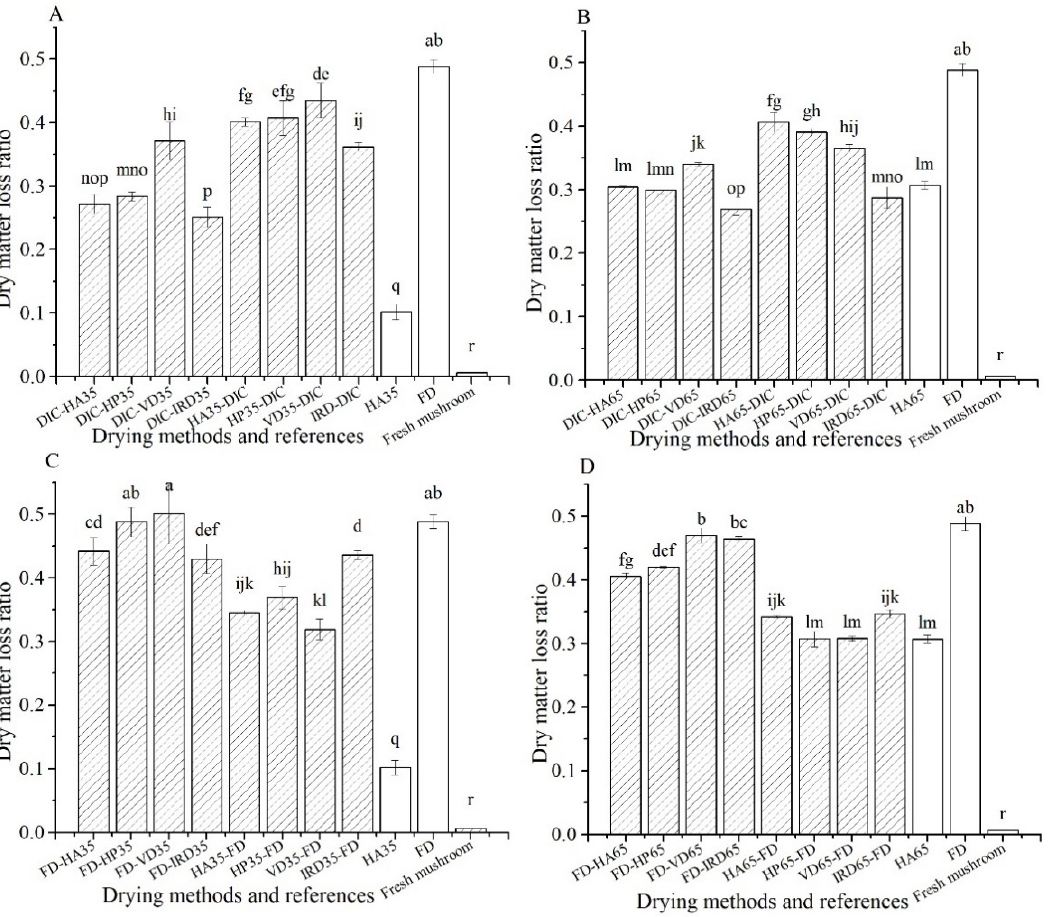
Figure 2. Volume recovery ratio of mushrooms after rehydration with different drying methods ( ) and references ( □ ). ( A–D ): group names as shown in Table1. ) and references ( (cid:3) ). ( A – D ):